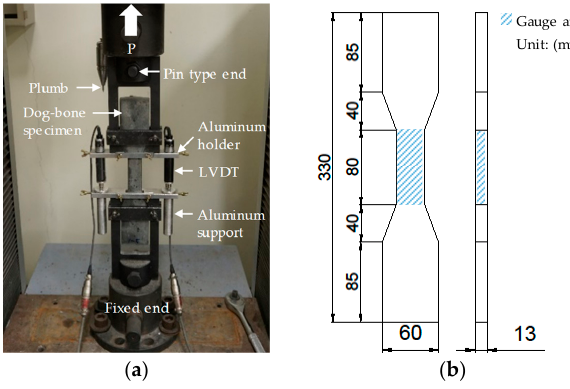
Figure 1. Tensile test ( a ) setup ( b ) geometrical details of specimen.